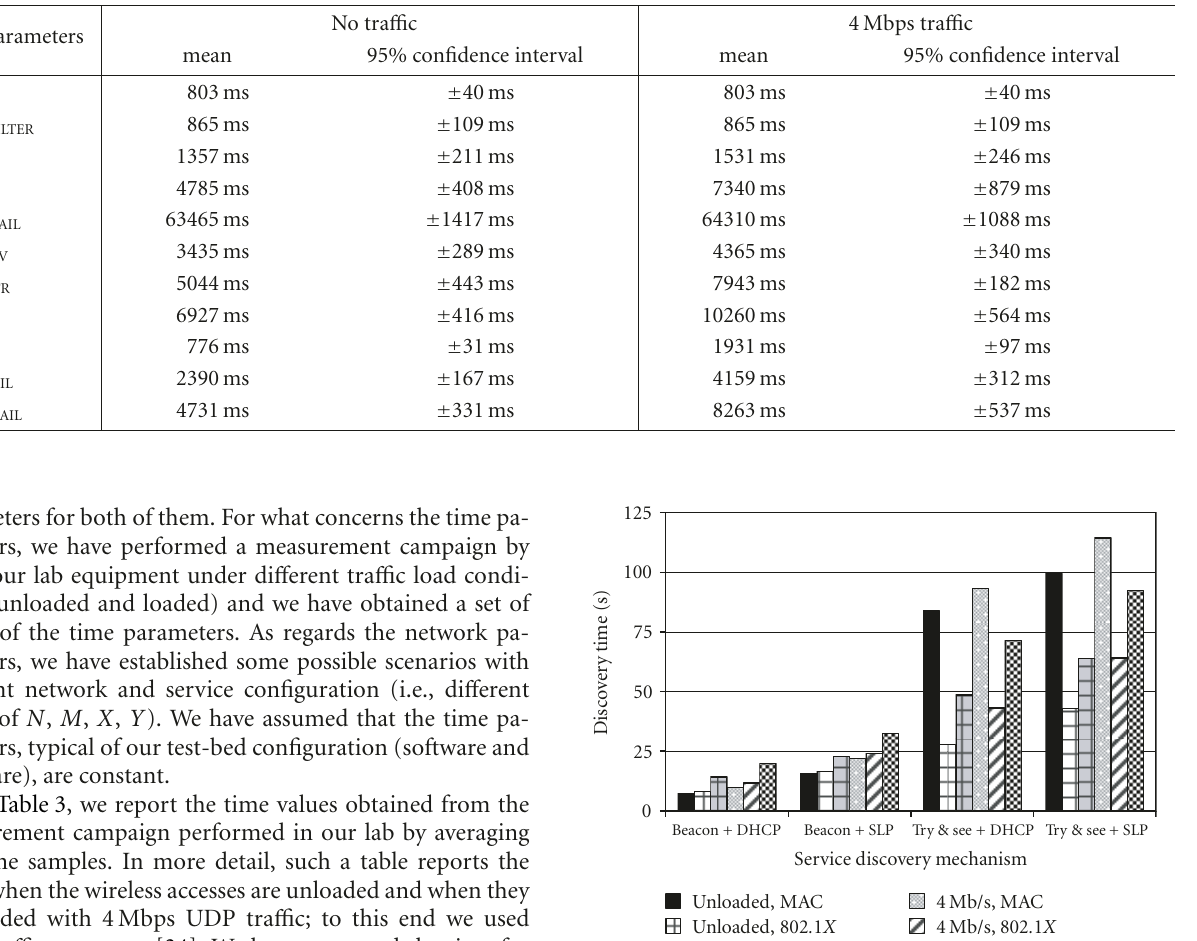
Table 3: Measurement results.